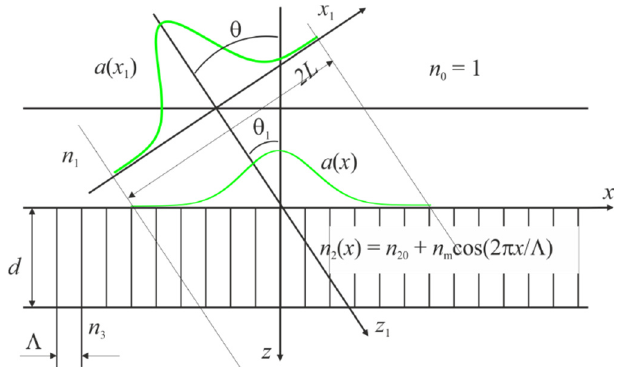
Figure 1. Incident of Gauss beam on the grating. The reflection coefficient is equal to 1 if the plane wave incidents on the grating and waveguide resonance occurs.